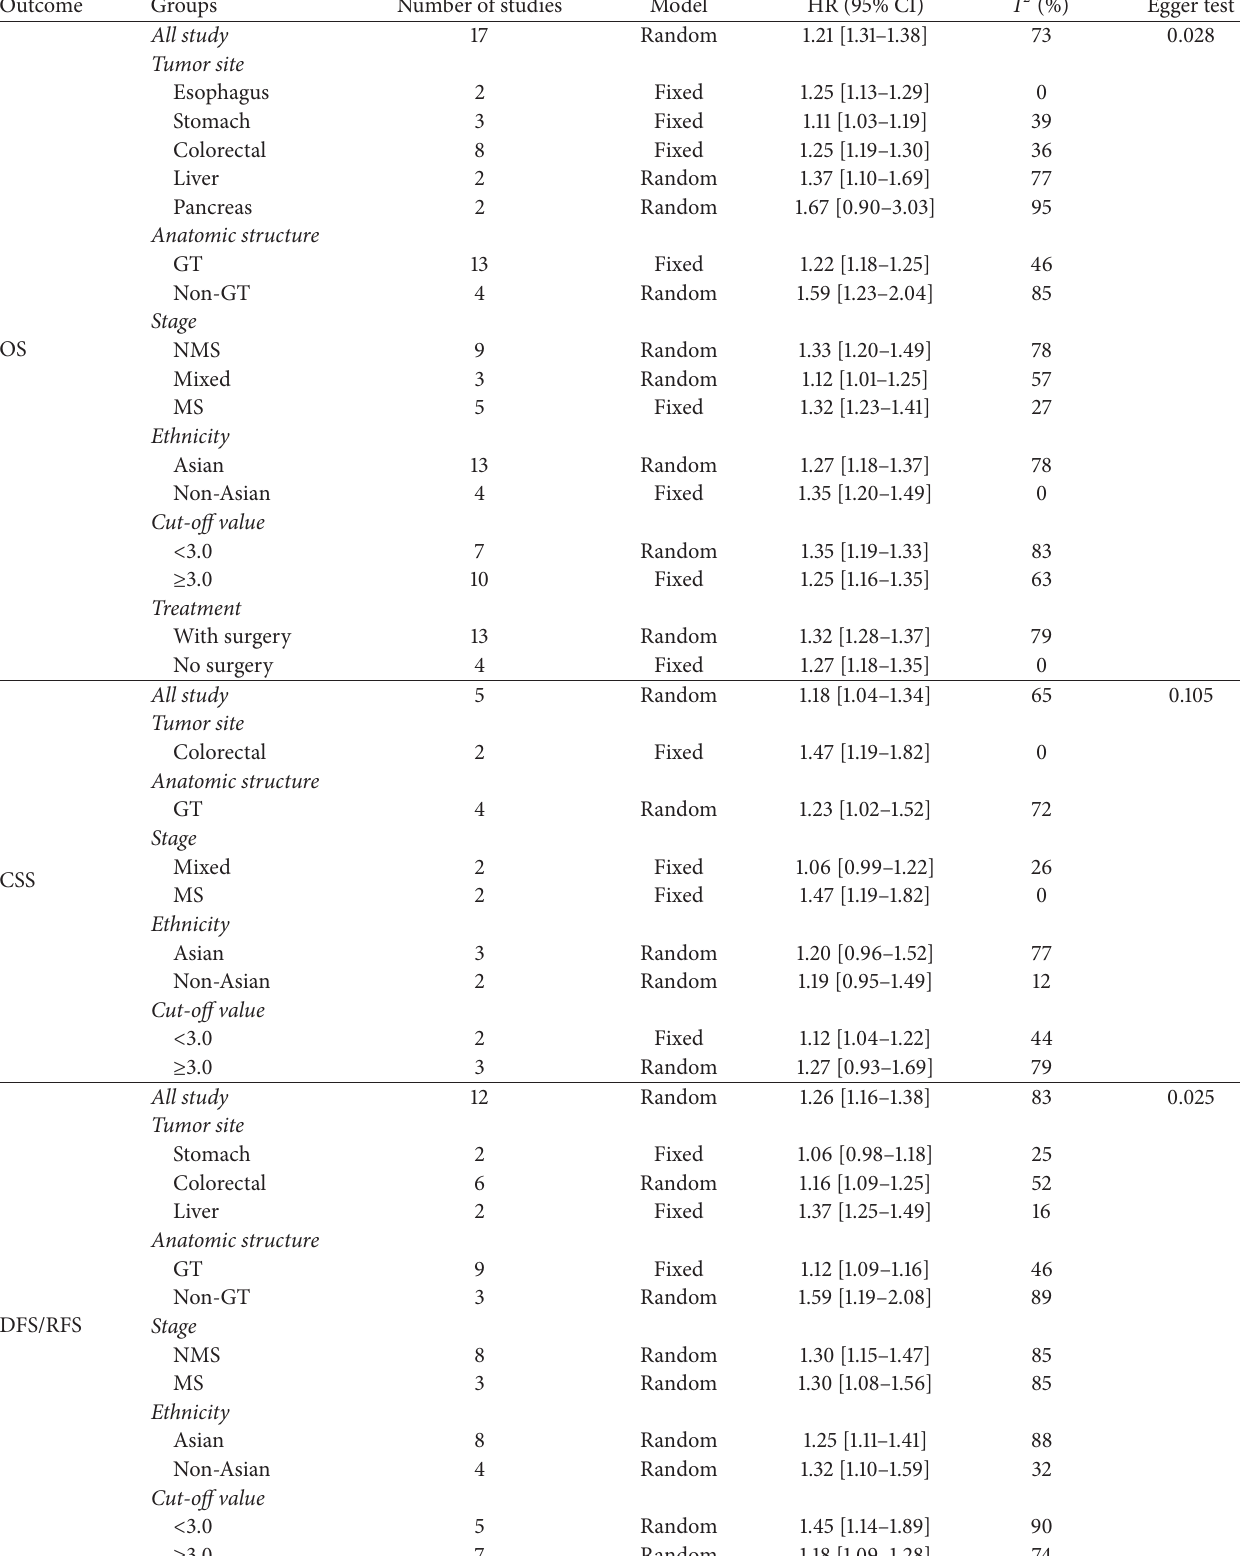
Table 3: Meta-analysis of HRs from multivariate survival